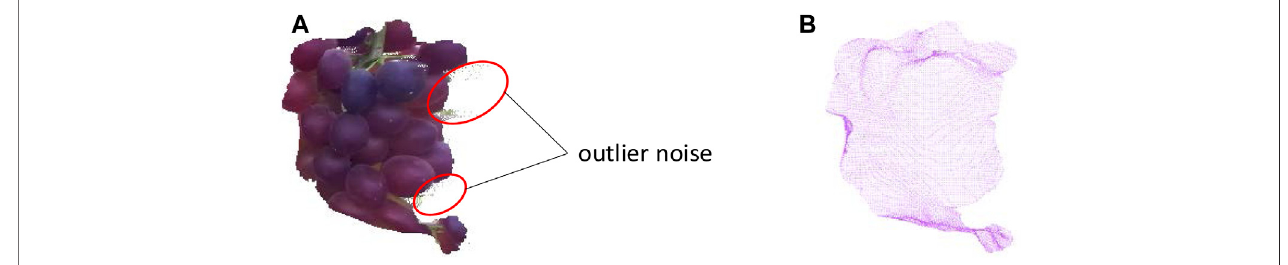
FIGURE 6 | Grape point cloud (A) before and (B) after